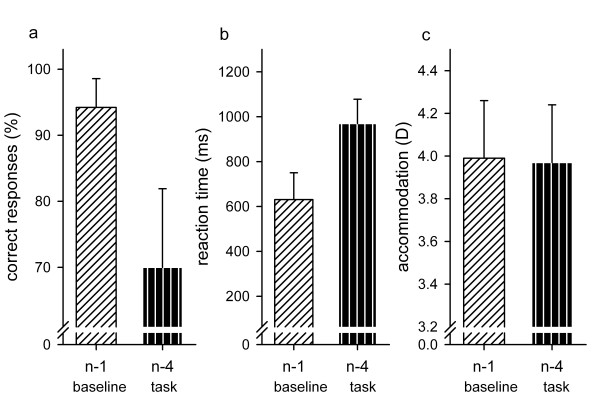
Results of Experiment 4. Average results for the additional control block of experiment 4 as function of task content (n-1 or n-4): in a. the amount of correct responses (%), in b. the reaction time (ms) and in c. the accommodation response (D) are shown; SDs are indicated as error bars. Only the amount of correct responses and the reaction time changed significantly with the task content.